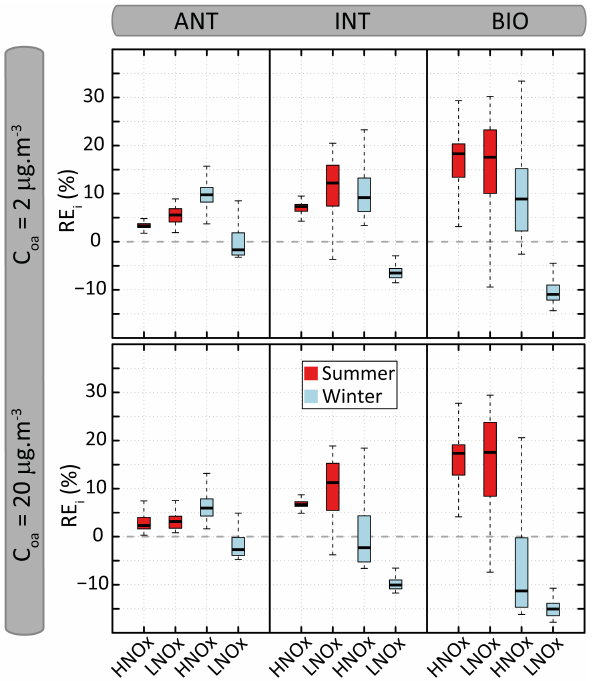
Figure 9. Distribution of the relative errors (RE i ) on organic aerosol mass concentration calculated between VBS-GECKO and GECKO- A for the 24 evaluation scenarios. The bottom and top of the boxes are the first and third quartiles; the bands inside the boxes represent the medians. The ends of the whiskers represent the lowest and the highest RE i values. There are 361 time steps for each evaluation